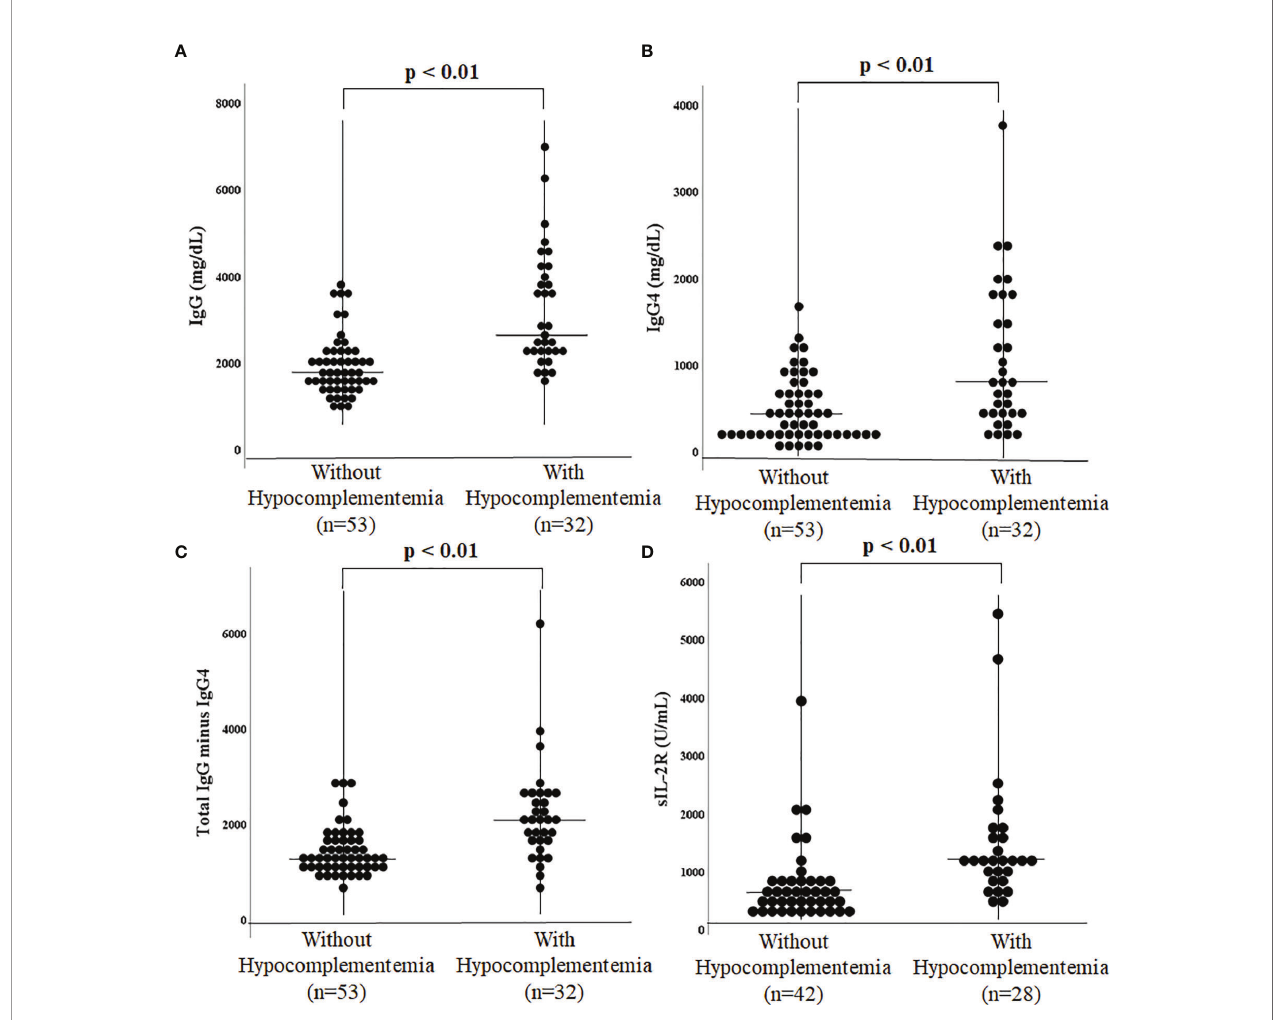
FIGURE 1 | Comparison of immunoglobulin G4-related disease with and without hypocomplementemia. Serum IgG (A) , IgG4 (B) , total IgG minus IgG4 (C) , and soluble IL-2R (D) in patients with hypocomplementemia were signi fi cantly higher than those in patients without